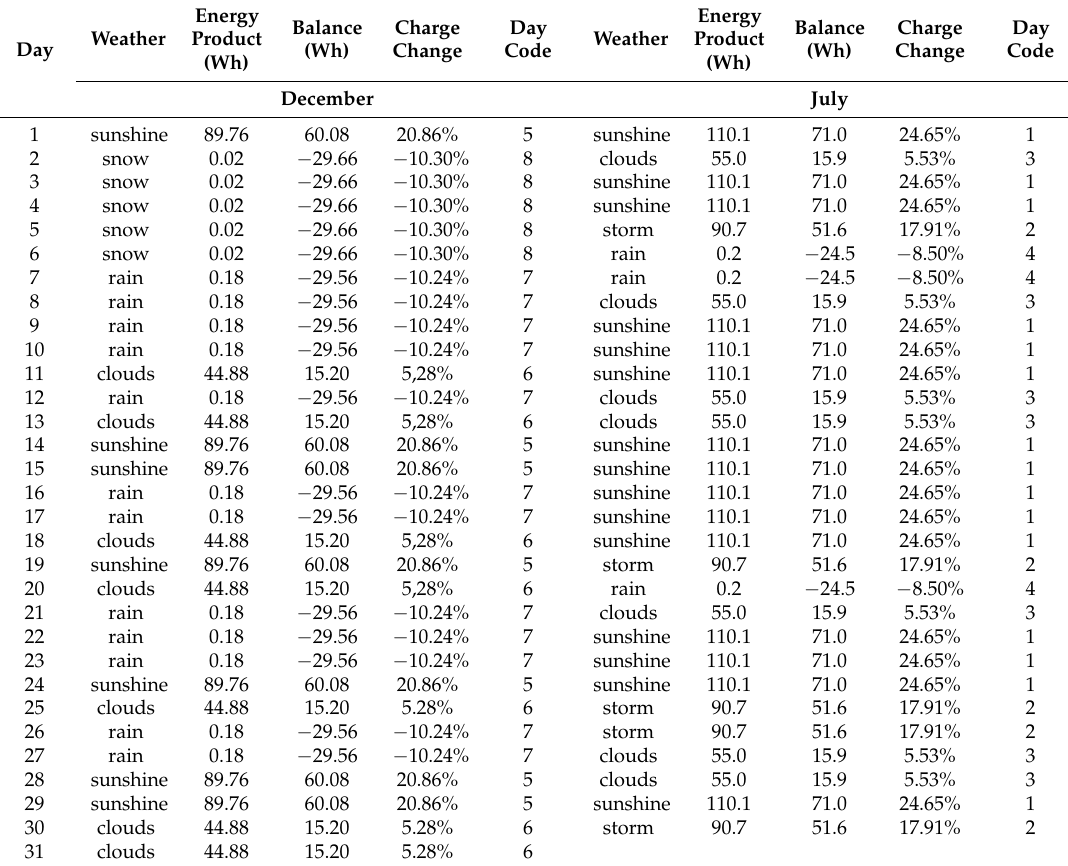
Table 3. Daily data of simulations on extreme